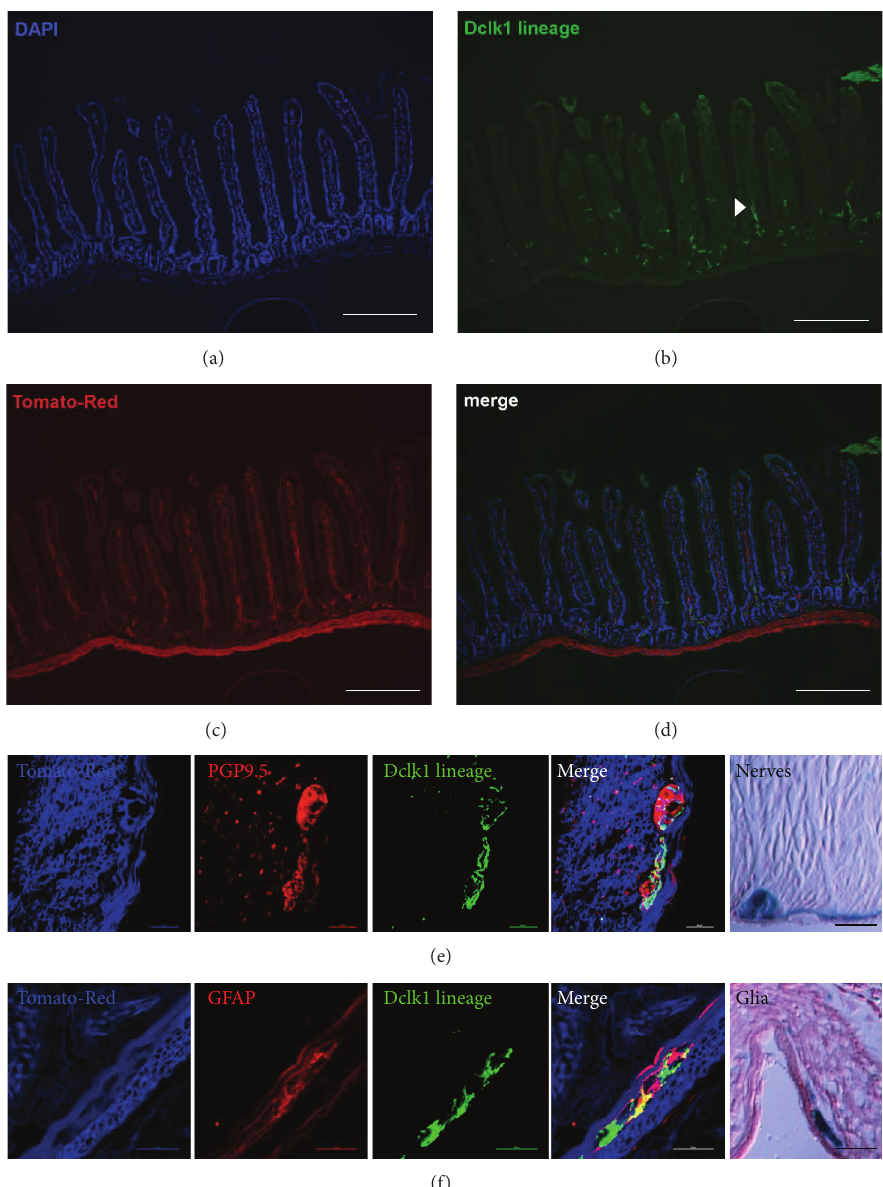
Figure 5: Positive Dclk1 lineage shown in the enteric nervous system with GFP labeled neurons. Immunofluorescence of small intestine from Dclk1.Cre.GFP-Tom fl/fl GFP mice. (a) DAPI for cell nuclei. (b) Positive GFP-fluorescence in neurons ( Dclk1.Cre.GFP-Tom fl/fl GFP label recombined cells of the Dclk1 lineage from birth on) invading organoids and single Dclk1-positive cells in epithelium, arrowhead indicating lineage of Dclk1-positive neurons, (c) Tom-Red ubiquitously expressed as marker protein complex. (d) Merge of (a)–(c), scale bars 100 𝜇 m. (e) Cultured neurons identified by positive GFP-fluorescence and overlapping with PGP9.5 staining as proof of lineage, last panel demonstrating lacZ stained neuronal structures next to smooth musculature within the GI tract, scale bar, 50 𝜇 m. (f) Overlapping fluorescence with GFAP as proof of lineage of glia within myenteric plexus, last panel showing lacZ stained glia within myenteric plexus, scale bar, 50 𝜇